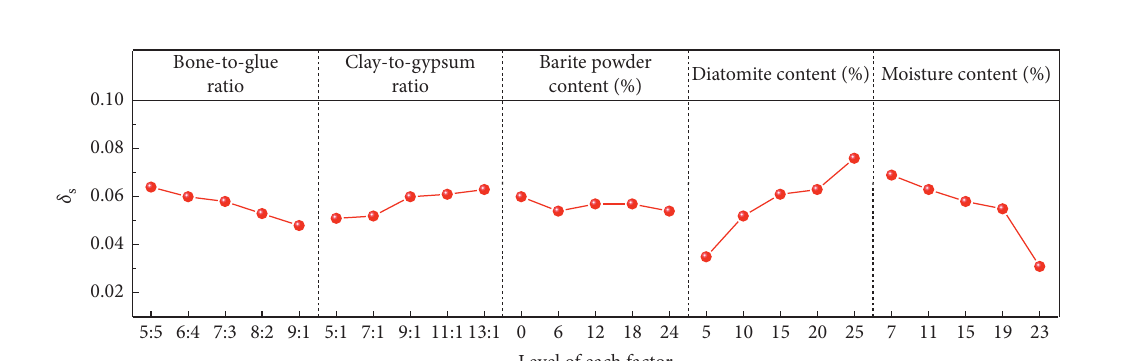
Figure 3: Intuitive analysis of collapsibility sensitivity.